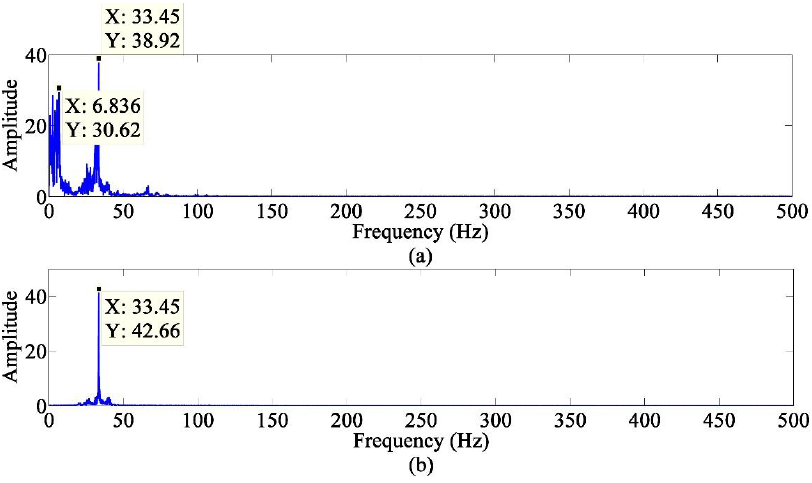
Figure 20. The Hilbert envelope spectra of the extracted fault signals after KICA. ( a ) The first fault signal. ( b ) The second fault signal.